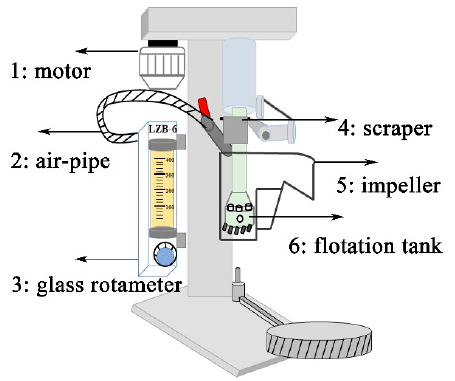
Figure 1. Schematic diagram of the flotation machine.